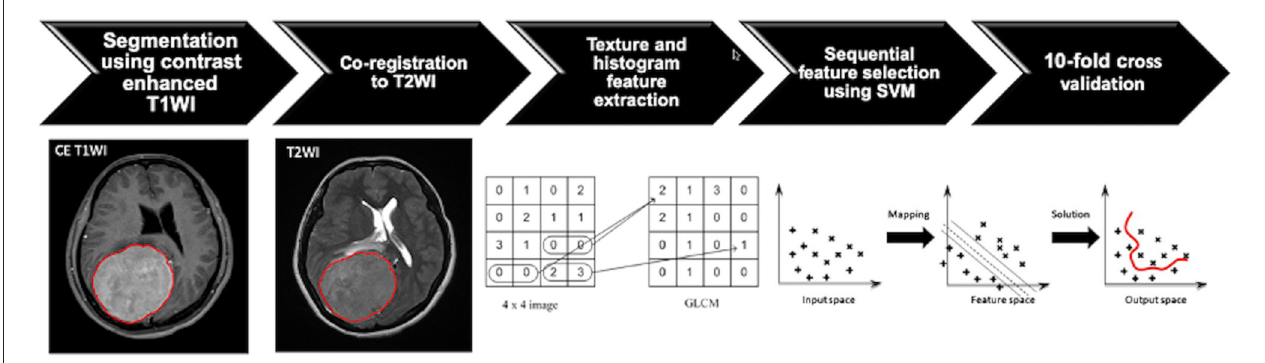
FIGURE 1 | Flowchart indicating the process of analysis for the prediction of progression/recurrence (P/R) in meningiomas. The tumor is first segmented based on contrast-enhanced (CE) T1-weighted image (T1WI), and the region of interest (ROI) of the tumor is then mapped onto the T2-weighted image (T2WI). On each set of the two sequences, a total of 32 first-order features and 75 textural features are extracted, and a total of 214 parameters for each case are collected to develop the classification model. The most important four features are selected by means of the sequential feature selection and support vector machine (SVM) classifiers to calculate SVM score. The 10-fold cross-validation method is applied to test the model